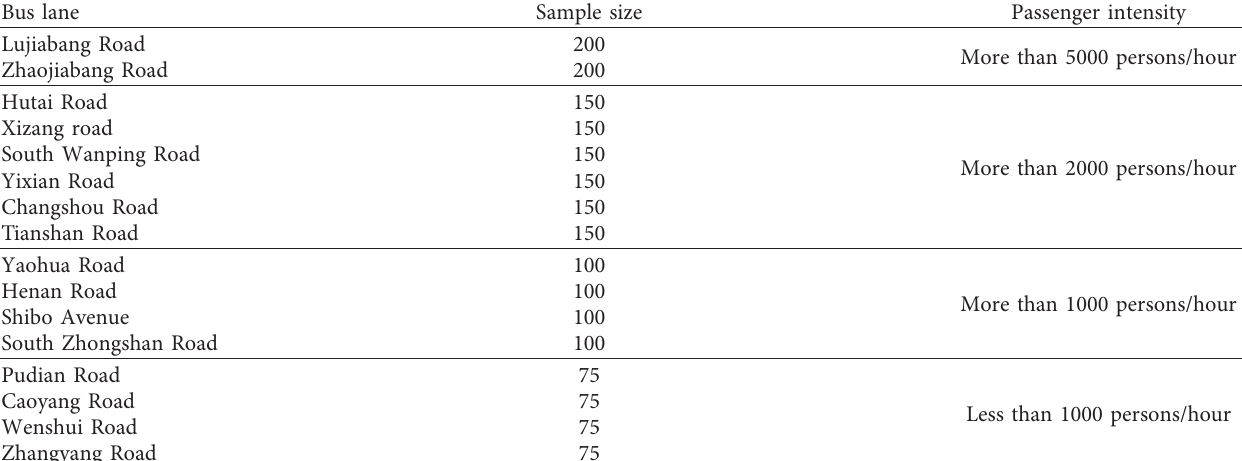
Table 2: Sample size of selected bus lanes.